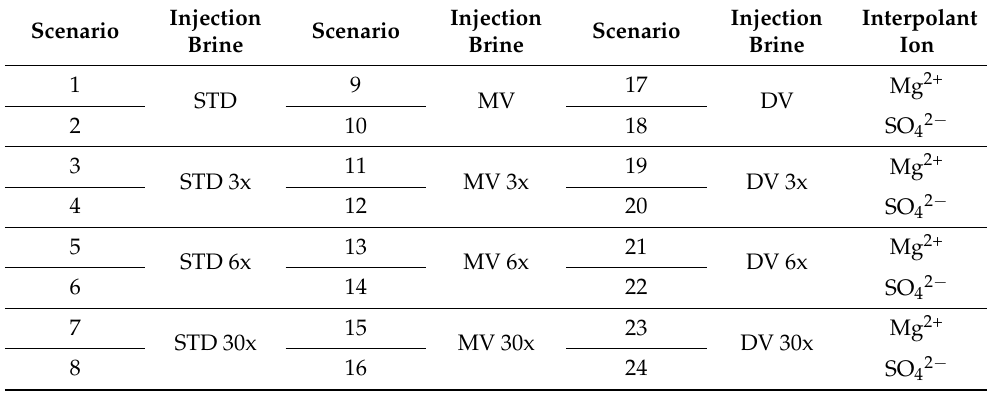
Table 4. Overview of all simulated scenarios in this study.